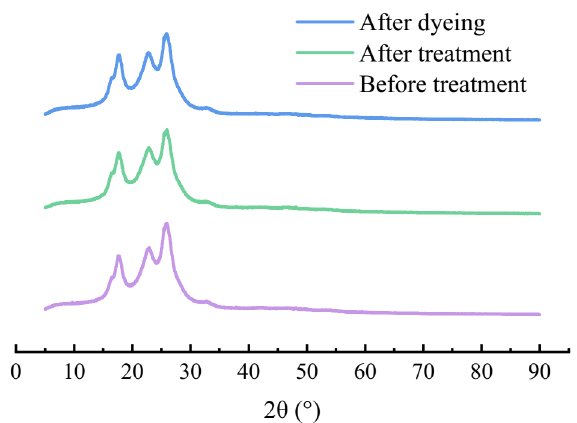
Figure 7. XRD spectra of the polyester fabrics before and after extraction (dyed sample was also used as a